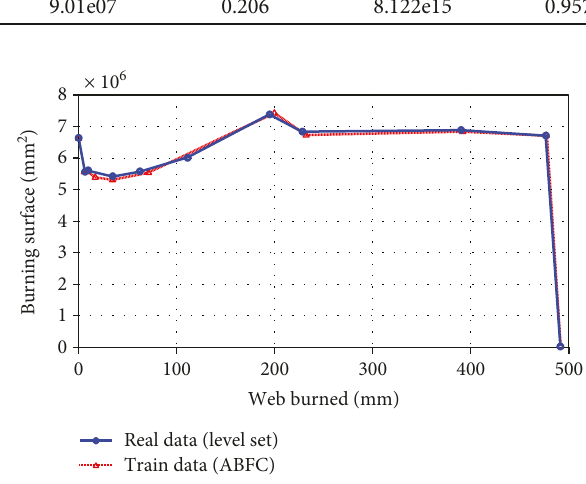
Figure 7: Comparing burning surface area real data output (from the level-set method) and training data based on the ABFC surrogate model. F = 220 , H = 50 , L = 180 , N = 13 , α = 25 , R 5 2 6 1 = 25 , H = 500 , F = 80 , F = 400 , L = 80 , L = 120 , L = 80 , 1 1 3 2 3 4 = 270 . and L 5